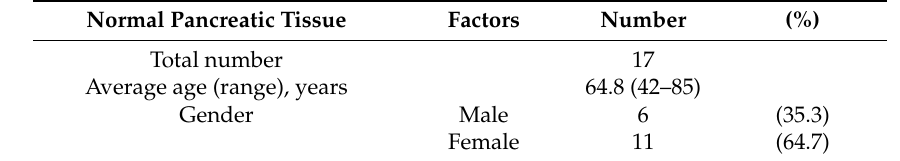
Table 2. Patient